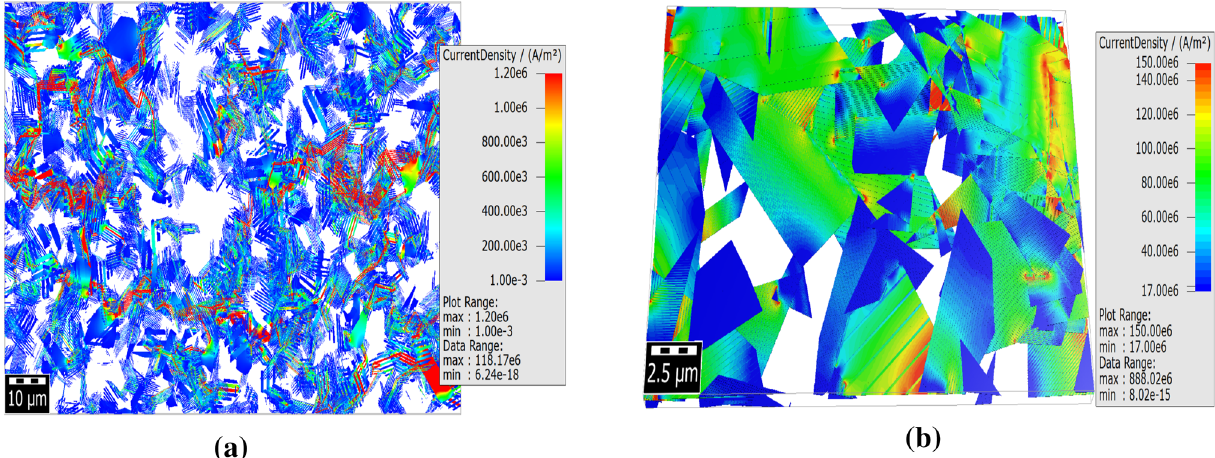
Fig. 3 Visualisation of the DC current distribution for the full-scale model a and a small detail b . Conduction paths are highlighted with red/ yellow